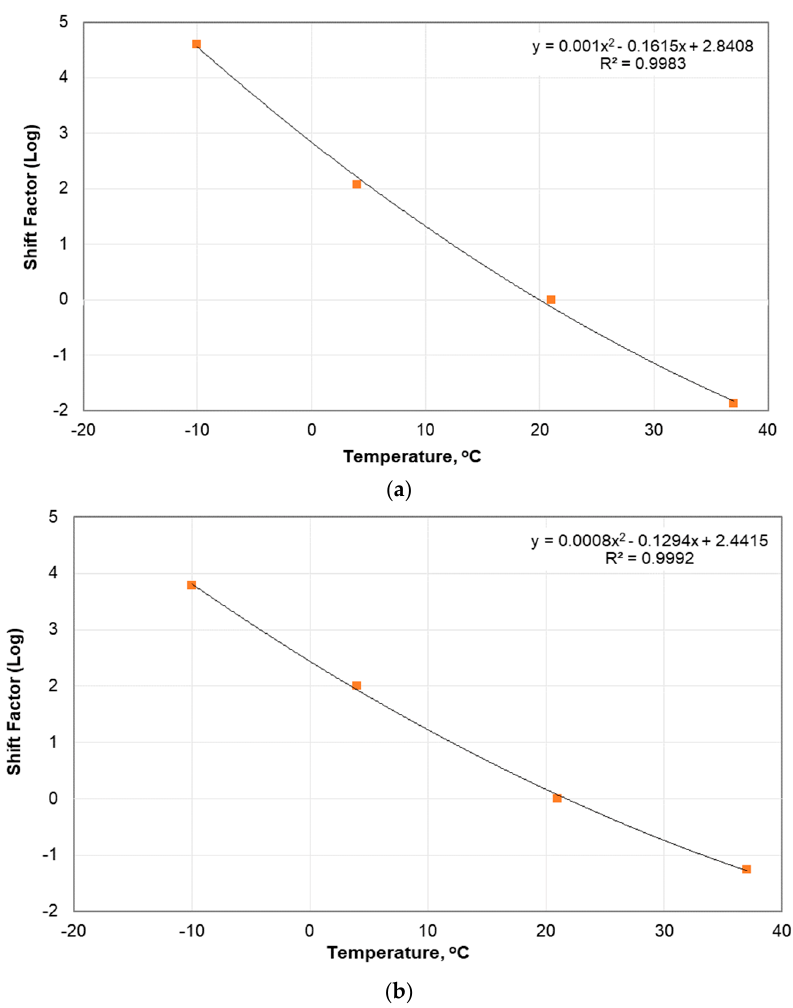
Figure 5. Shift factors for: ( a ) PA10; and ( b ) PA20.